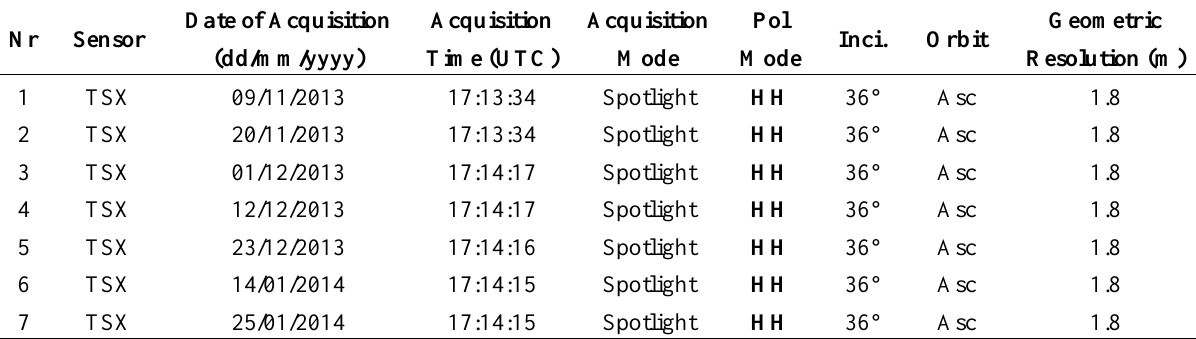
Table 1. Main characteristics of the X-band SAR images: Pol: Polarization, Inc: Incidence Angle, Desc: Descendant and Asc: